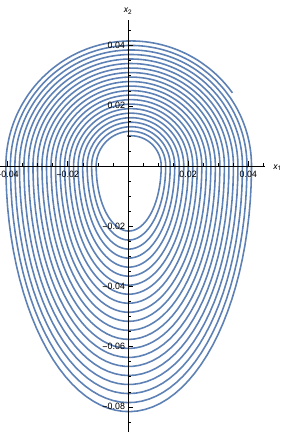
Figure 6. Solution of (54) for ε = 0.1 and x 1 ( 0 ) = 0, x 2 ( 0 ) =